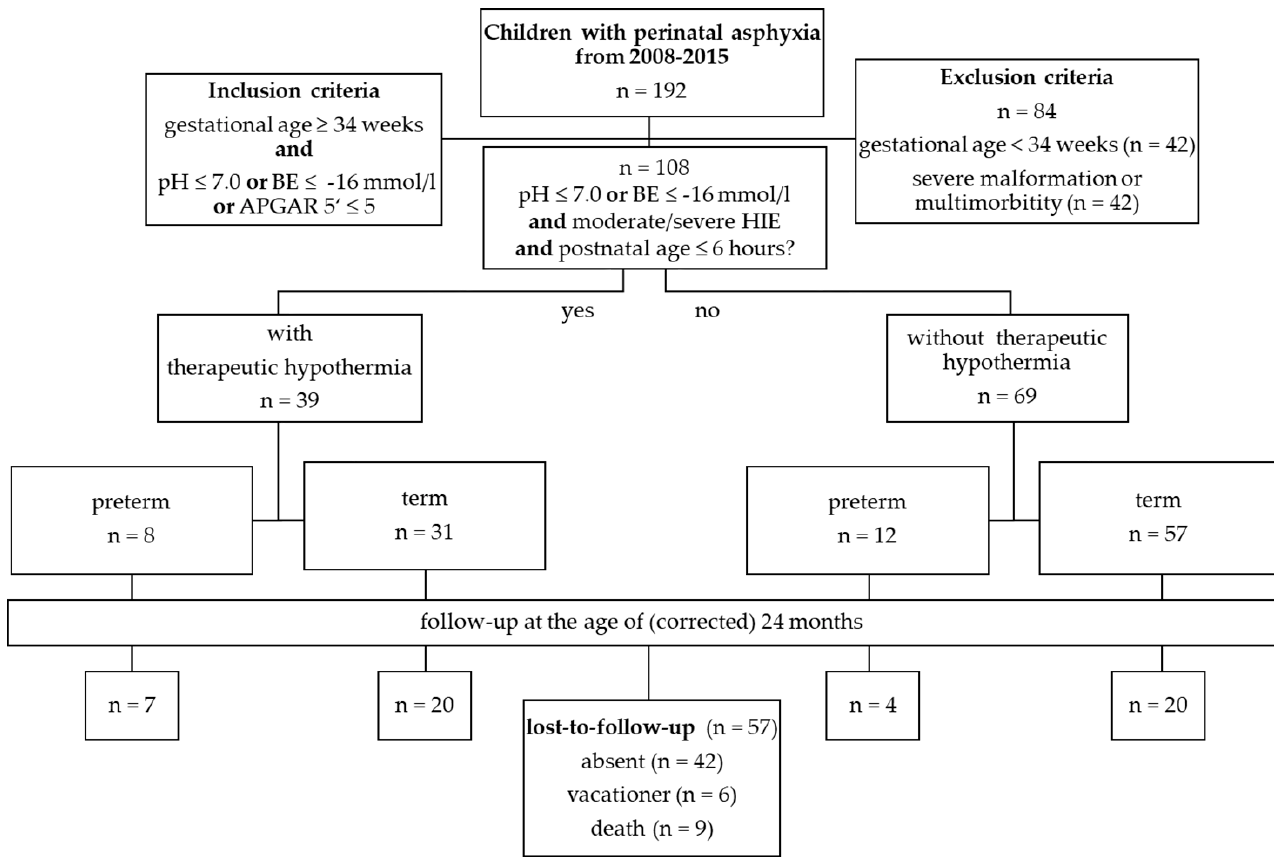
Figure 1. Overview of the inclusion and exclusion criteria of the study, therapeutic groups and follow-up-examinations. Overall, 192 children with perinatal asphyxia were identified between 2008 and 2015. A total of 109 infants met the inclusion criteria. A total of 39 infants showed clinical signs of a hypoxic-ischemic encephalopathy or correlating pathologic results in the amplitude-integrated electroencephalogram (aEEG) and were treated with THT. Eight of these infants were preterm new- borns. Follow-up examinations were conducted at the age of (corrected) 24 months. Abbreviations: